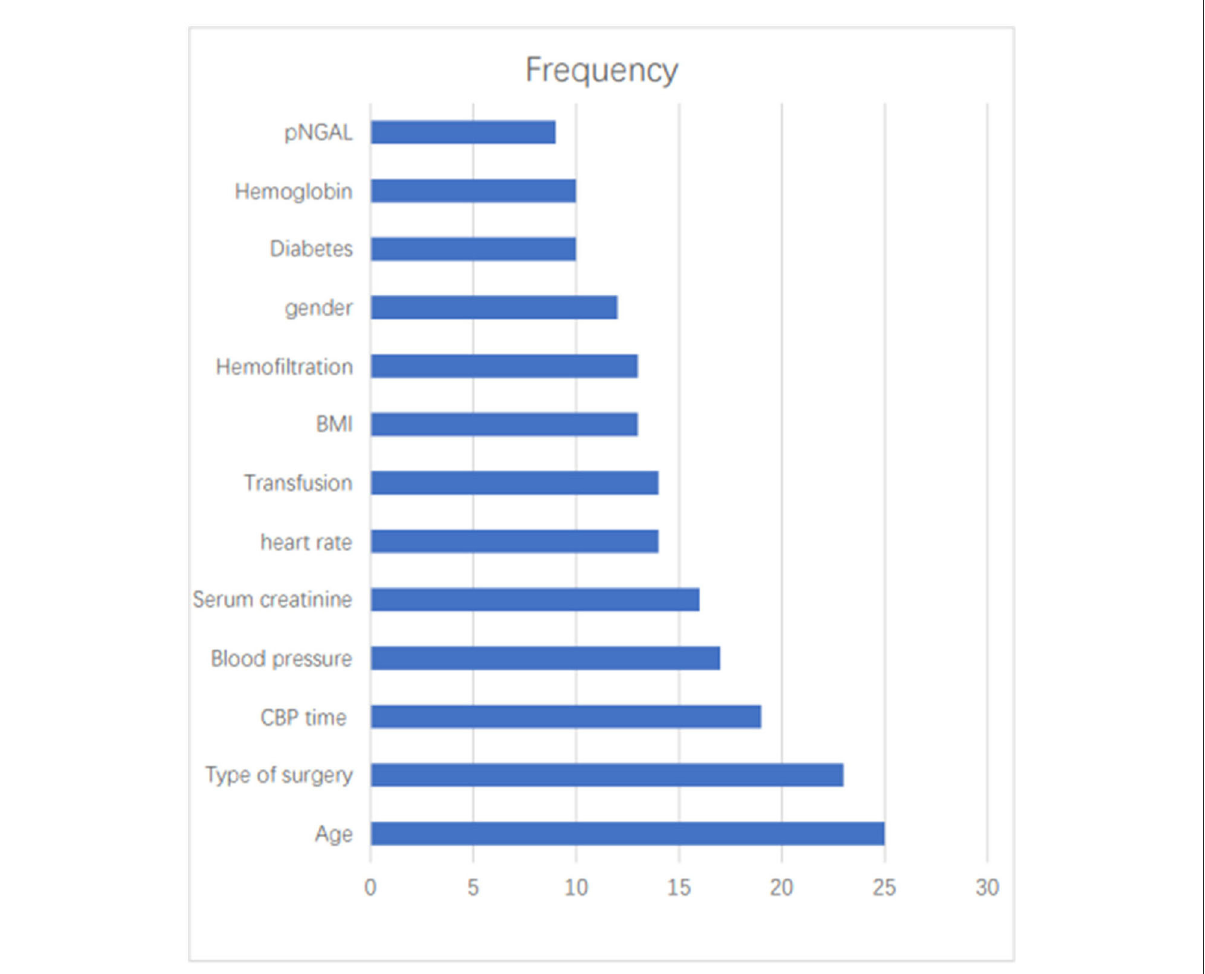
FIGURE2 A frequency bar chart of